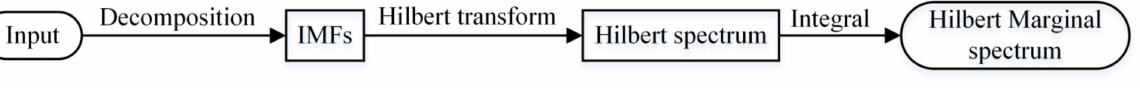
Figure 4. Signal processing flow chart using HHT